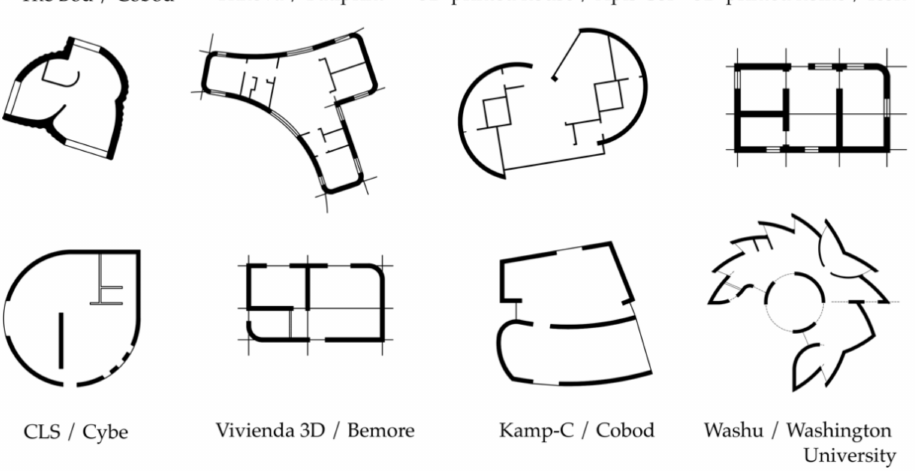
Figure 11. Plans of some 3D-printed constructions